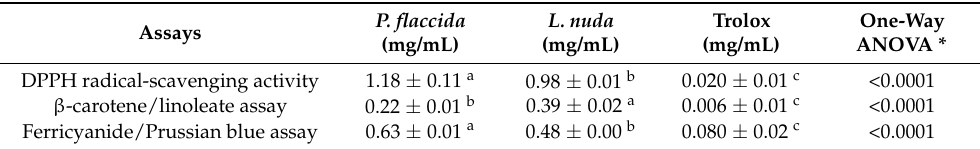
Table 4. EC 50 (mg/mL) of antioxidant properties of the methanolic extracts from Northern Morocco and of the standard Trolox ® .